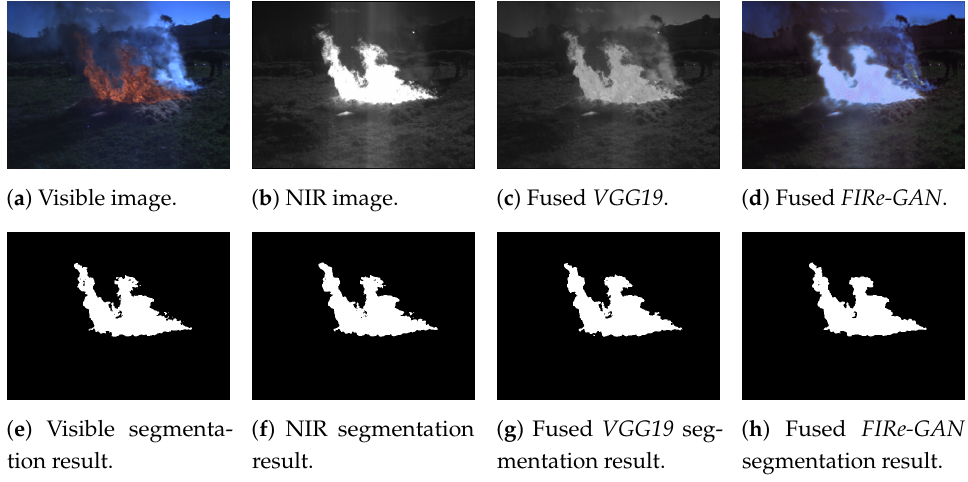
Figure 17. Sample segmentation results for all image types and the Akhloufi + Focal Tversky combination. Table 2. Top five performing combinations per metric. The best performing combinations per metric are highlighted in